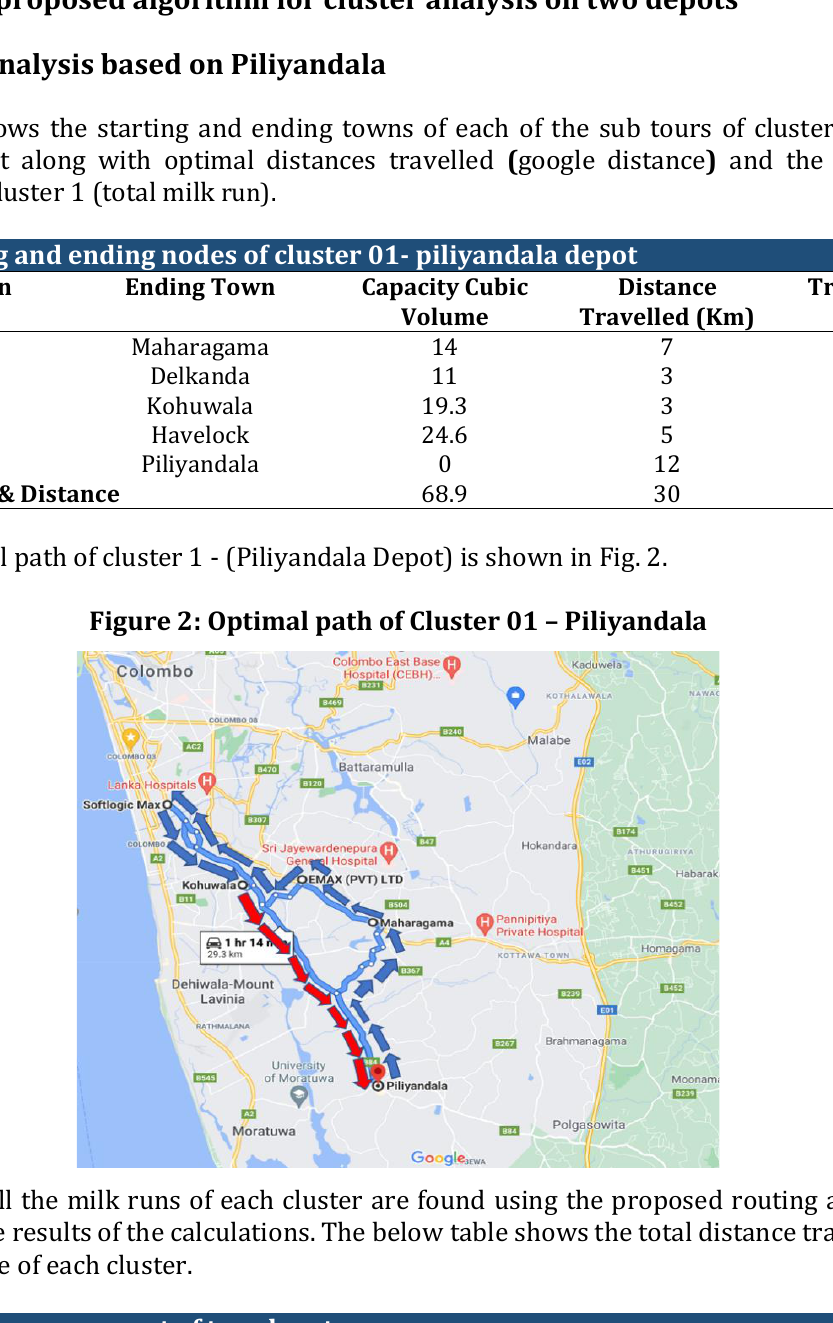
Table 3: Cluster arrangement of two depots